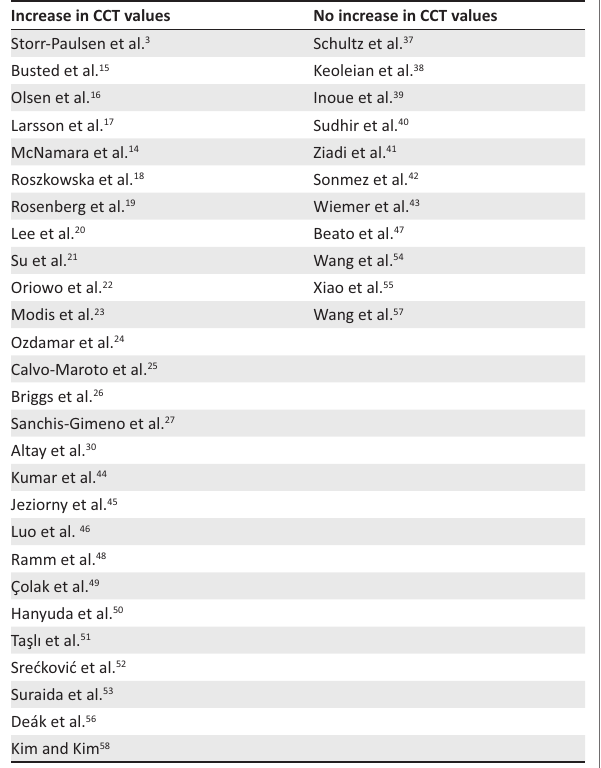
Increase in CCT values No increase in CCT values